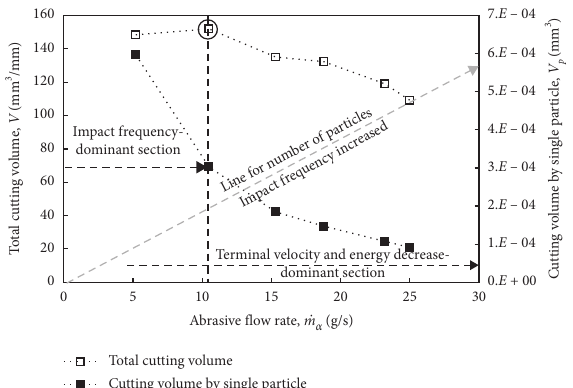
Figure 11: Accumulation of single-particle cutting volume at d